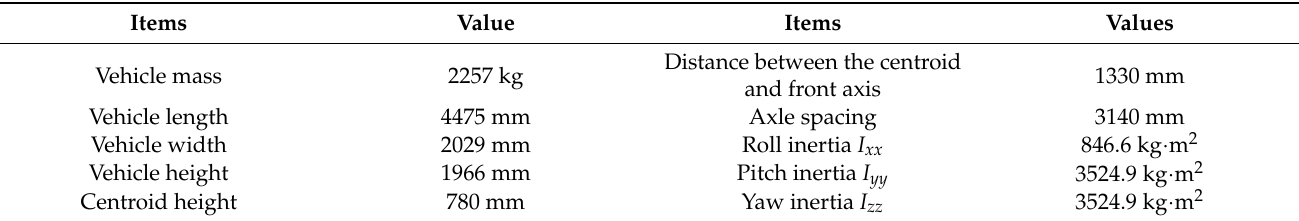
Table 3. Parameter settings of the vehicle body.